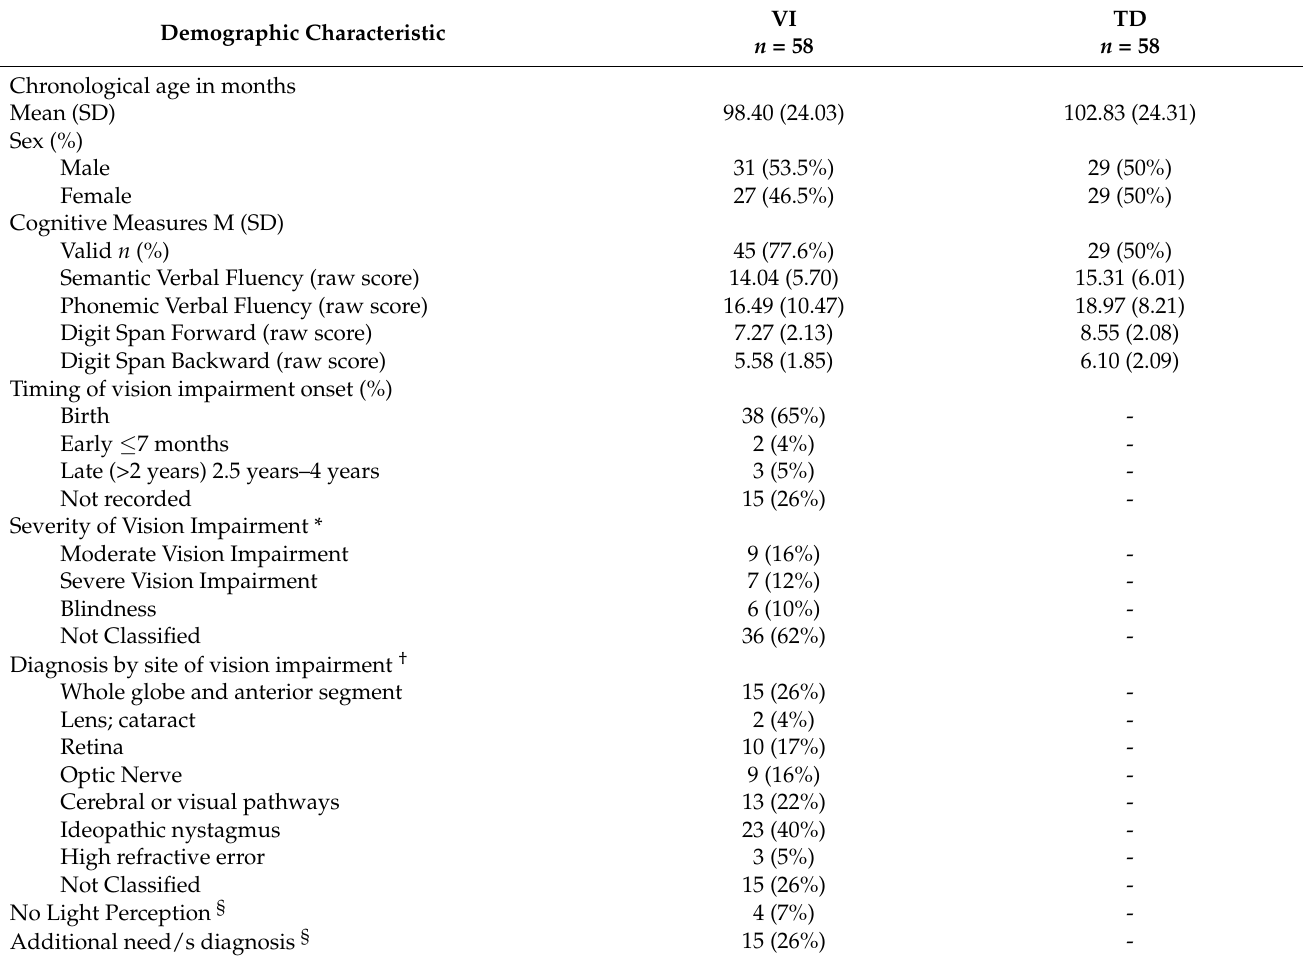
Table 1. Characteristics of the sample ( n =